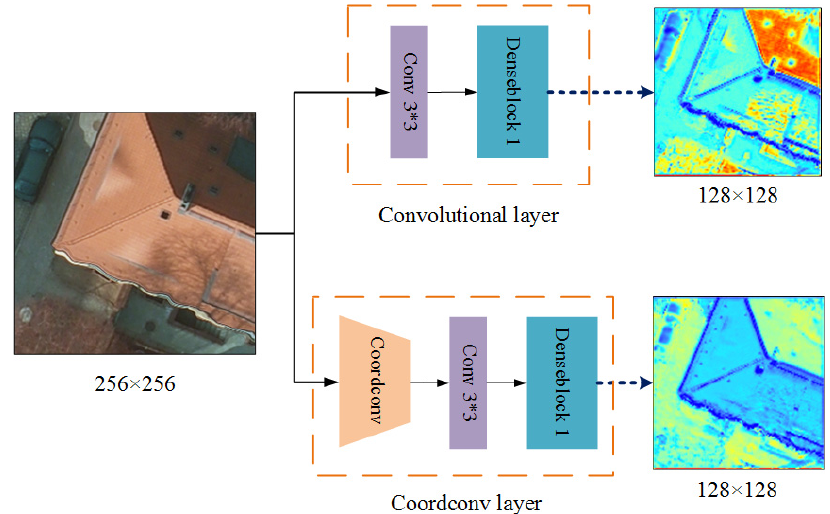
Figure 3. Comparison results between the convolutional and coordconv layers. The up route is a standard convolution including a 3 × 3 convolutional layer and a dense block. The down route is the coordconv layer including a coordinate convolution, a 3 × 3 convolutional layer and a dense block. The dense output maps are all 128 × 128.